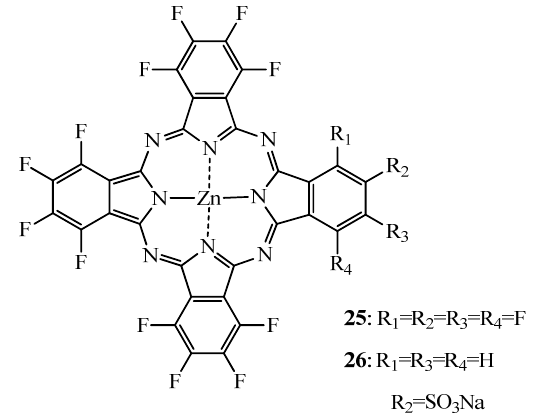
Figure 10. Structure of the zinc hexadecafluorinated Pc 25 and its monosulfonated analogue 26